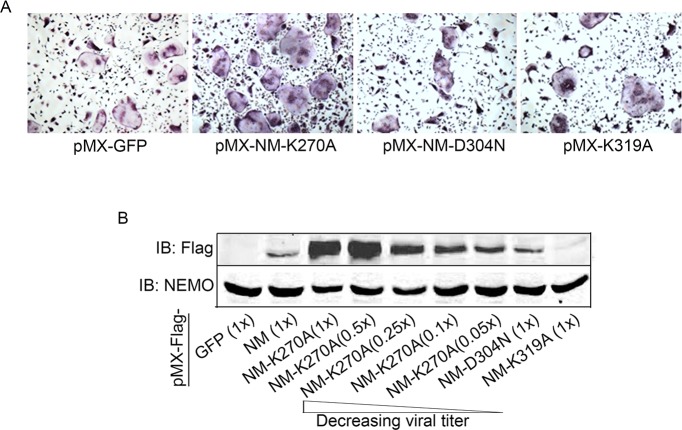
BMMs from wild type mice were transduced with viral particles (generated by transfecting pMX- retroviral vectors in PLAT-E cells) expressing NEMOWT (NM-WT), NEMOK270A (NM-KA), NEMO-D304N and NEMO-K319A constructs followed by culture in the presence of MCSF (10 ng/ml) and RANKL (50 ng/ml) for 4 days.(A) Representative images for TRAP staining for osteoclast (n = 8). (B) Wild type BMMs were transduced with different dilution (1x, 0.5x, 0.25x, 0.1x and 0.05x) of retroviral particles expressing NEMOK270A (NM-KA). Wild type BMMs were also transduced with viral particles expressing NEMO-D304N and NEMO-K319N at 1x dilution. Western-blot using anti-flag antibody shows higher expression of NEMOK270A even at low viral dilution. pMX-Flag-NEMOWT-RFP (NM-WT), pMX-Flag-NEMOK270A-RFP (NM-KA).